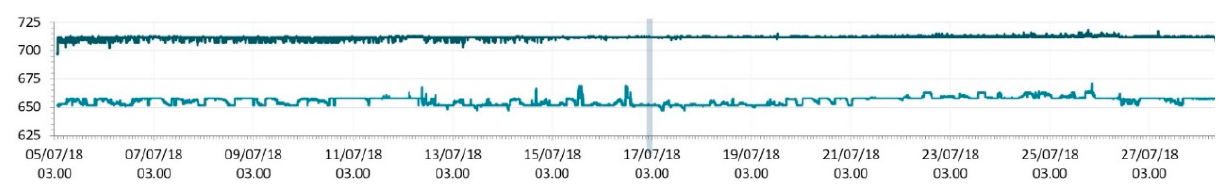
Figure 9. Raw patterns of valve openings of the two individuals of P. casertanum included in the second study group, from 5 to 28 July 2018: HUB03-01 in blue colour, HUB03-02 in heavenly colour.